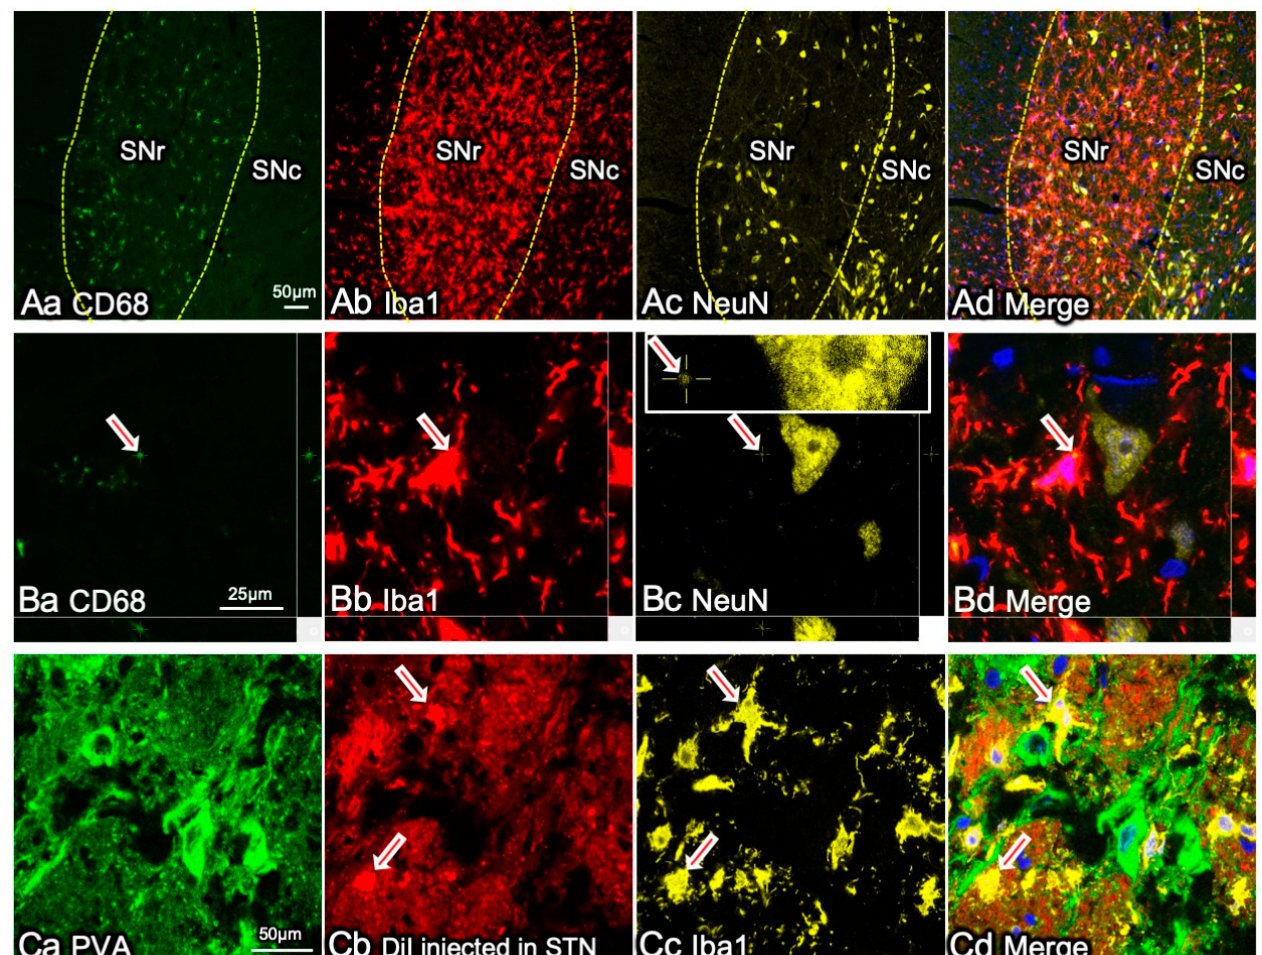
Figure 4. Microglial activation is more pronounced in SNr and GPi than in SNc. ( A ) Activated microglia with elevated CD68 expression are more densely present in SNr rather than in SNc in a rat 6-OHDA-induced PD model brain. The cryosection was triple-immunostained with antibodies to a phagosome marker CD68 ( Aa ), a microglial marker Iba1 ( Ab ), and a neuronal marker NeuN ( Ac ). ( B ) An activated microglial cell in SNr has a CD68 + phagosome (arrows) in its cytoplasm that contains NeuN + materials (an arrow in inset in ( Bc )), indicating that the cell phagocytosed some neuronal elements. ( C ) Activated microglia in the GPi phagocytosed nerve terminals from the STN. Lipophilic red fluorescent DiI was injected into the STN. The DiI was transported on the axonal membrane to the GPi. Activated Iba1 + microglial cells internalized DiI (arrowheads in Cb , Cc , and Cd ). GABAergic neurons are identified with immunoreactivity to parvalbumin (PVA; Ca ). The methodology for these results is described elsewhere [68].